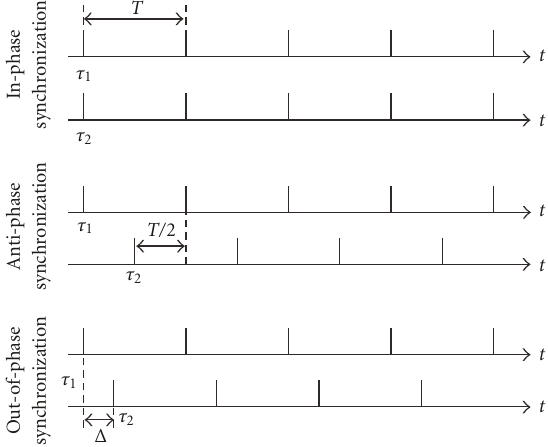
Figure 4: Synchronization regimes of pulse-coupled